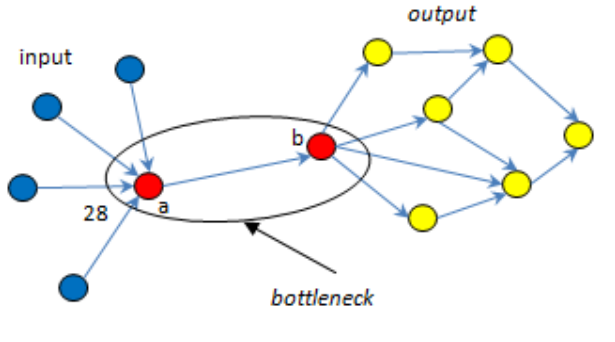
Figure 8. Example of a bottleneck in metabolic